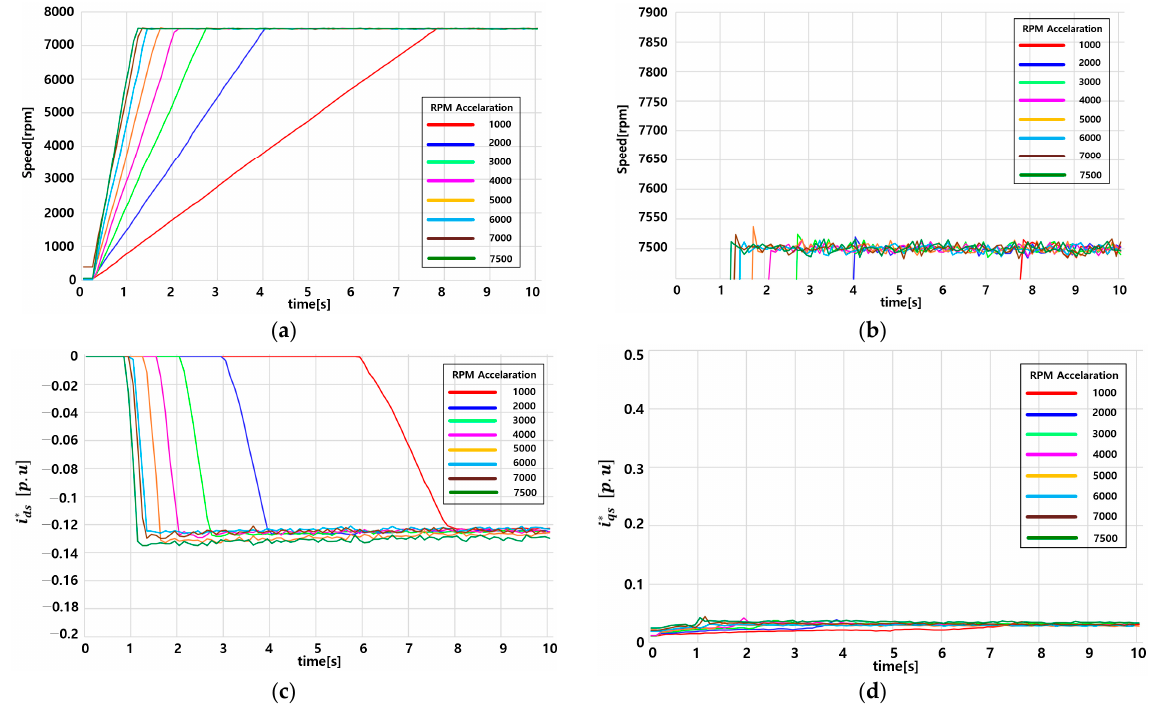
Figure 12. Experimental results when ∆𝑖 (cid:3031)(cid:3046)∗ is optimized: ( a ) motor speed; ( b ) motor speed; ( c ) d-axis current; ( d ) q-axis current.